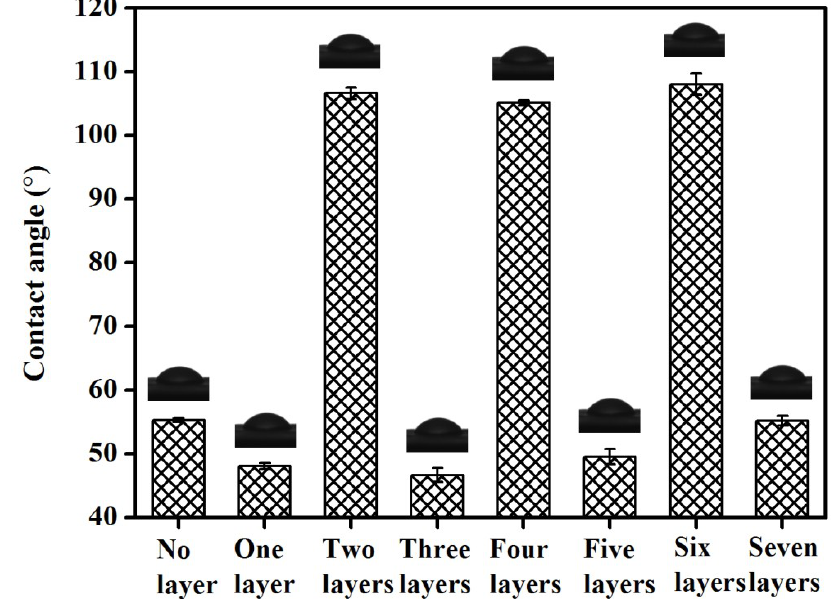
Figure 4. Contact angle values of different coating layers on the mango surface. Error bars represent the standard deviations of three replicates.